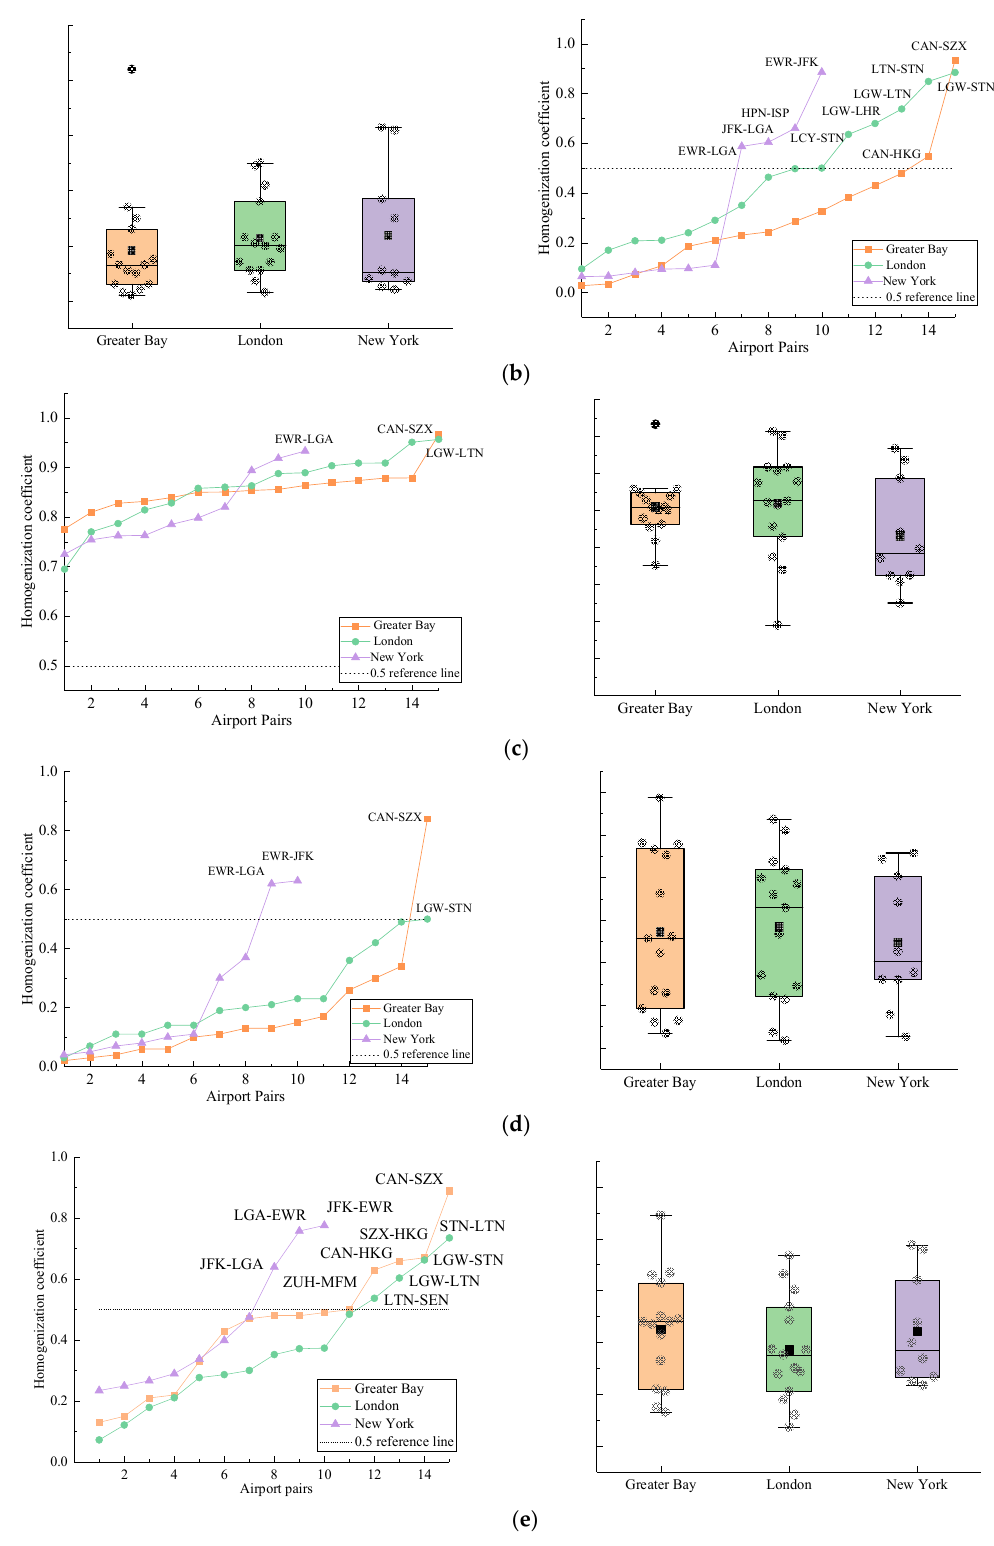
Figure 6. Illustration of second layer comprehensive homogenization: ( a ) Homogenization level and analysis boxplots of BF; ( b ) Homogenization level and analysis boxplots of IS; ( c ) Homogenization level and analysis boxplots of OE; ( d ) Homogenization level and analysis boxplots of RN; ( e ) Homogenization level and analysis boxplots of BS.